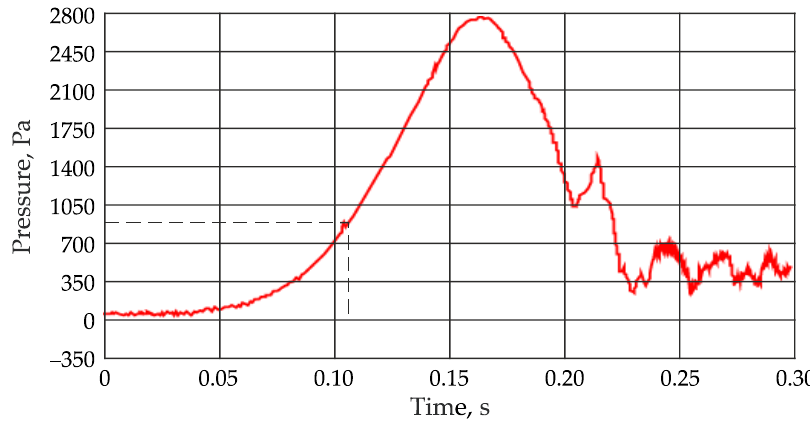
Appl. Sci. 2021 , 11 , x FOR PEER REVIEW Figure 5. Experimental waveforms of excessive pressure when testing EVS #1 sample.